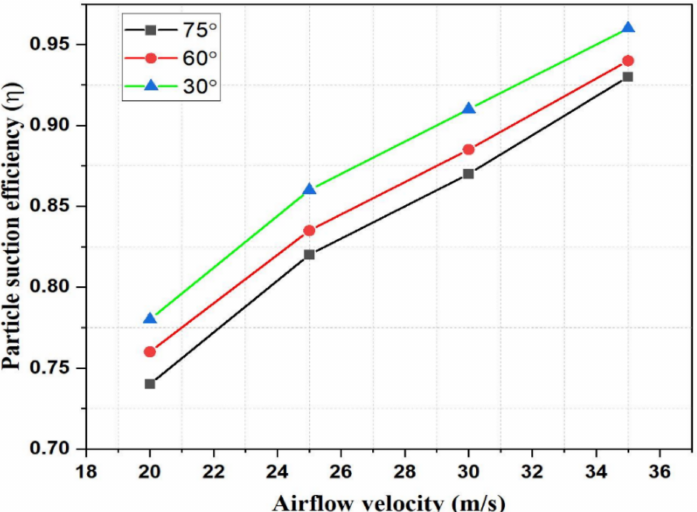
Figure 11. Experimental result of particle suction efficiency with different inclination angles of the suction port.